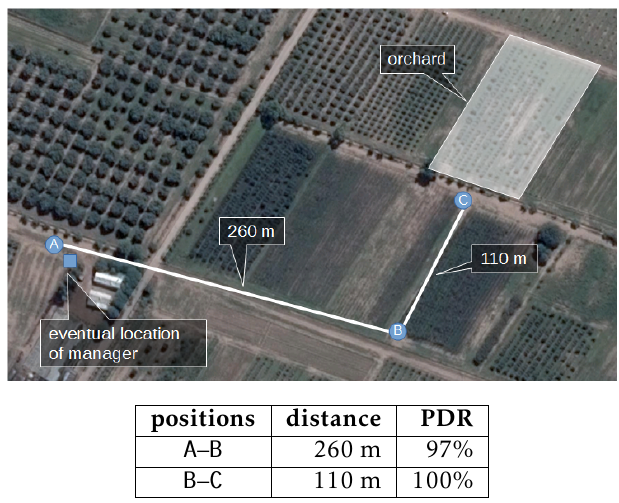
Figure 7. Range testing using long-range prototype boards.